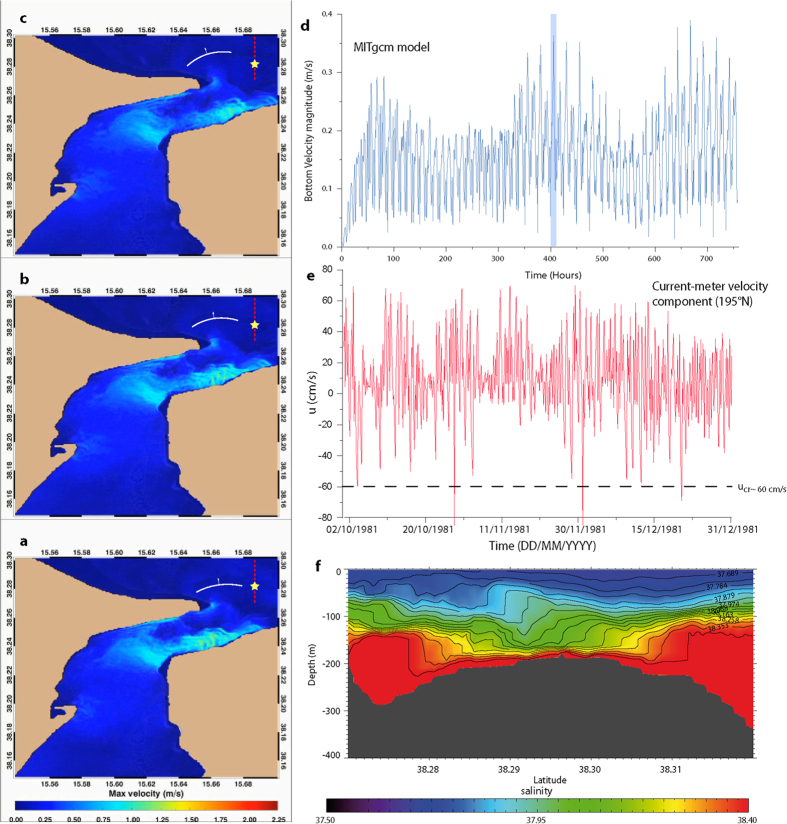
Observations and model results.(a–c) Snapshots from the MITgcm numerical simulation showing the bottom velocity magnitude during the northward tidal current (See panel (d) and Movie S1 in Supplementary Information). The white arch shows the passage of the refracting ISW over the topographic mound (see Fig. 1a). The yellow star indicates position of the NOMEC3 current-meter. The dashed red line corresponds to the vertical transect in (f). Maps are generated by IDL 8.0 (www.harrisgeospatial.com/IntelliEarthSolutions/GeospatialProducts/ IDL.aspx). (d) Bottom velocity field for the MITgcm numerical simulation over the sand waves field. The vertical shaded (blue) bar indicates the passage of the ISW showed in panel (a–c) and (f)). (e) Time series of the velocity magnitude (velocity component toward 195°N) recorded by the NOMEC3 current-meter (from 1 October 1981 to 31 December 1981). The two extremely large peaks (>80 cm/s) demonstrate the intense northward velocity due to the ISW passage (see orientation of the reference system in Fig. 1a). The dashed line indicates the flow speed that marks the critical value for sediment transport. (f) Salinity cross-section along transect in (a–c) as obtained from the MITgcm numerical simulation. The isohalines show the passage of a concave-up ISW over the topographic mound. Note that the MITgcm model, being hydrostatic, cannot simulate the change of polarity of the ISW due to the topographic effects.